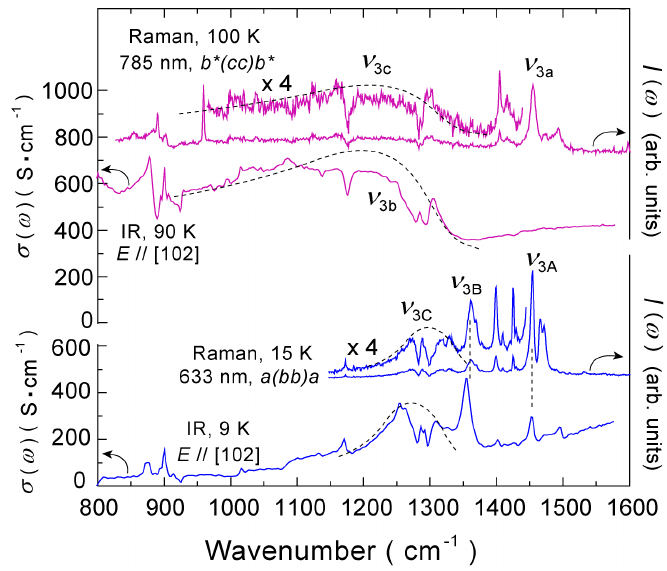
Figure 10. Comparison between the IR and Raman spectra above and below the CO transition temperature. In both temperatures, the number of ν exclusion rule is applicable (not applicable) to both IR and Raman spectra above (below) the transition temperature.